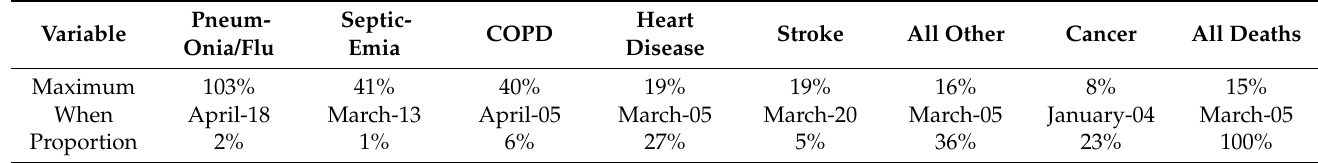
Table 1. Maximum value of EWM (Excess Winter Mortality) in Michigan for various conditions (2000–2020), when the maximum occurred, and the proportion of total deaths due to that